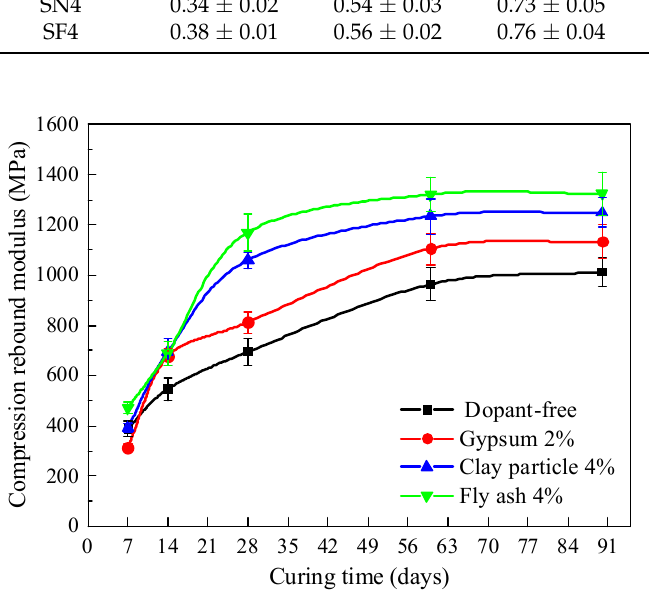
Figure 9. Compression rebound modulus with different replacement ratios of the additives. Table 7. Test results for compression rebound modulus (MPa).